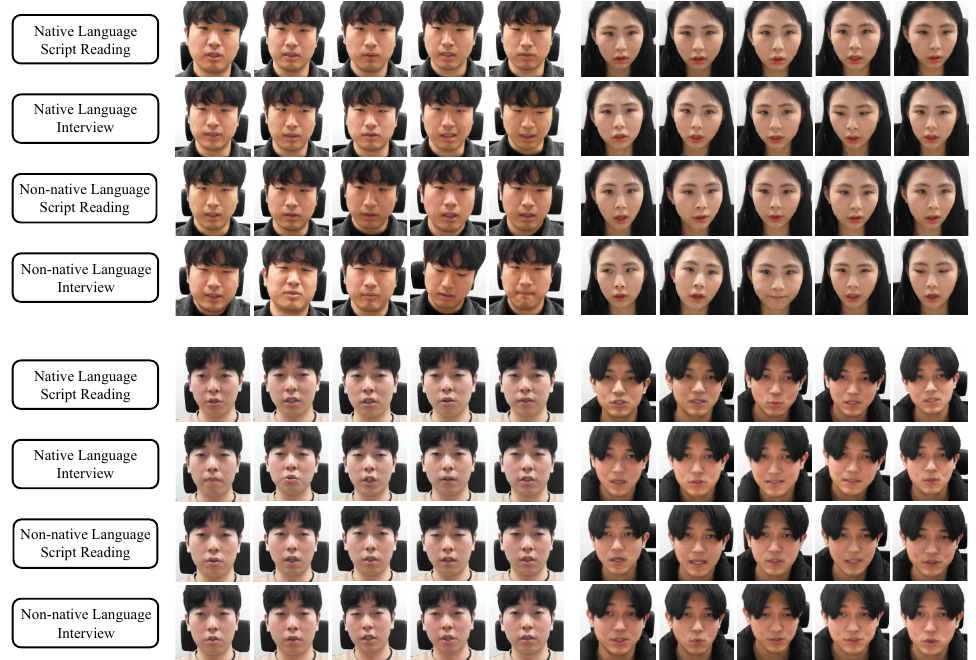
Figure 6. Samples of cropped facial images from the constructed